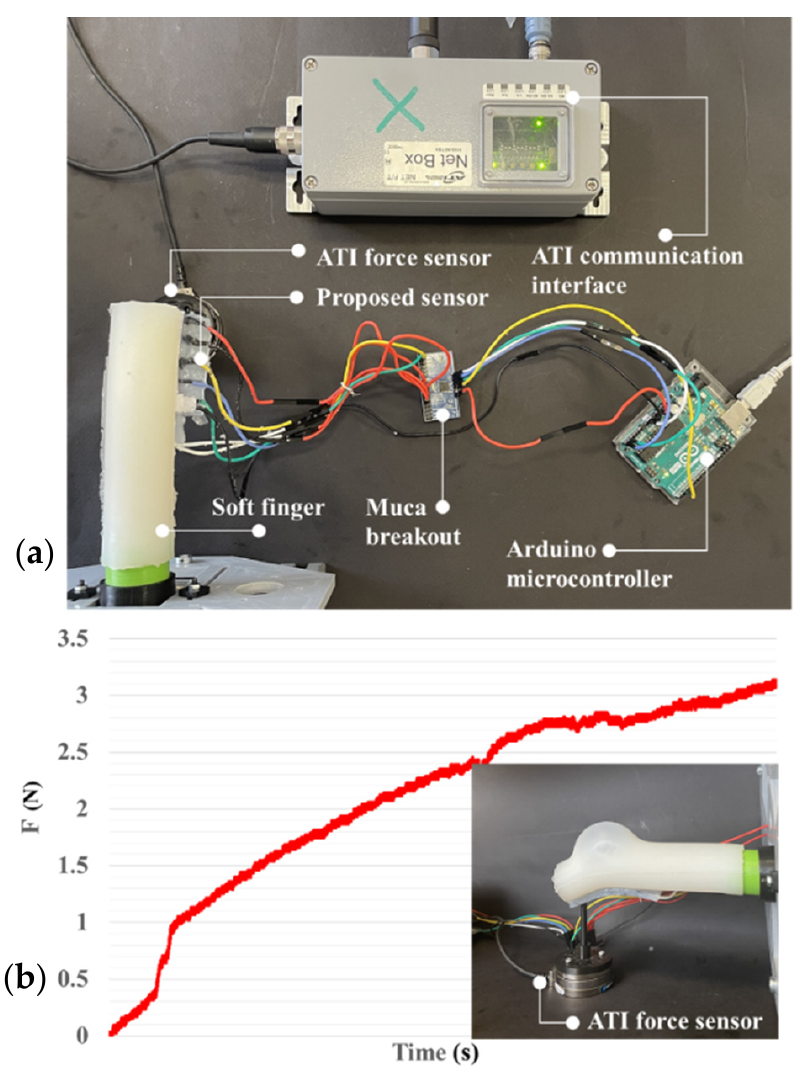
Figure 8. ( a ) Calibration setup assembly and ( b ) testbench for measuring the finger’s force.